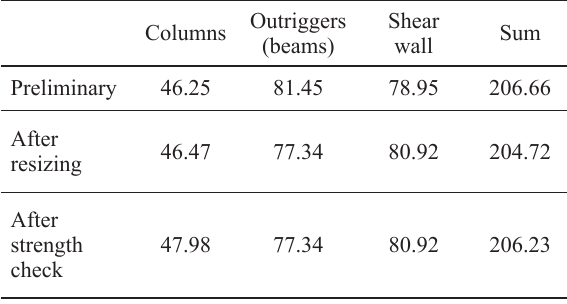
Table 1. Weight change of the example according to the application of the resizing method (Unit: MN) Outriggers Columns (beams)